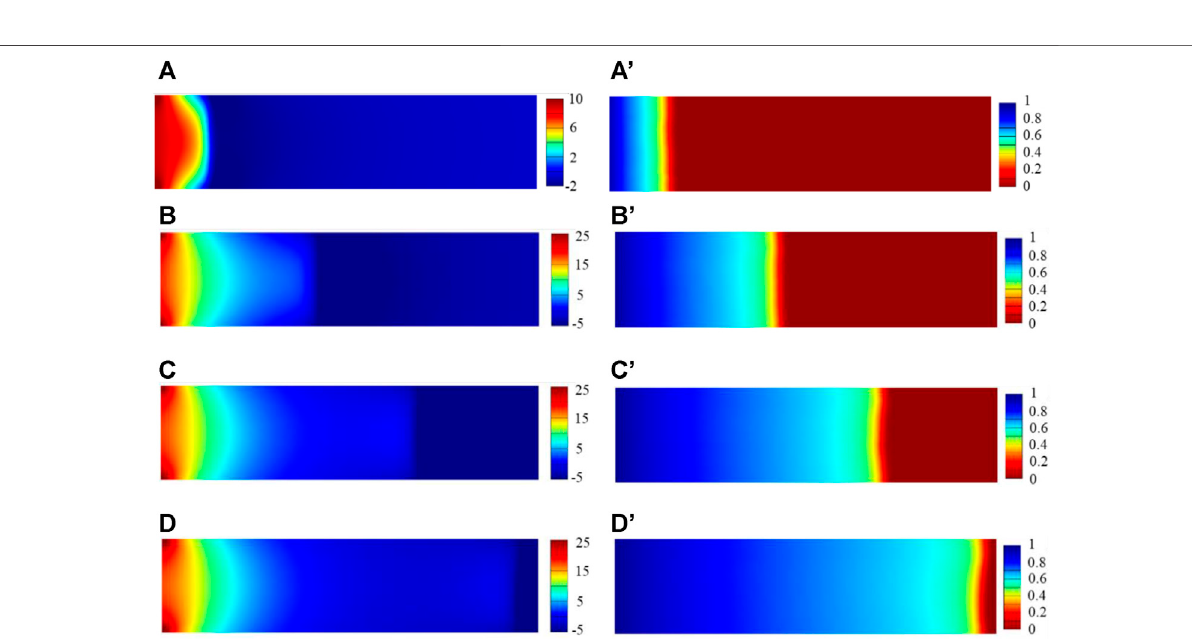
Frontiers in Earth Science |